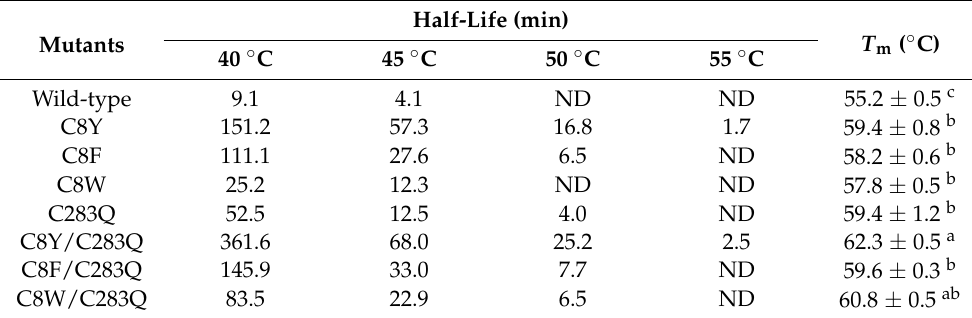
Table 2. Half-lives and T m values of mutants.